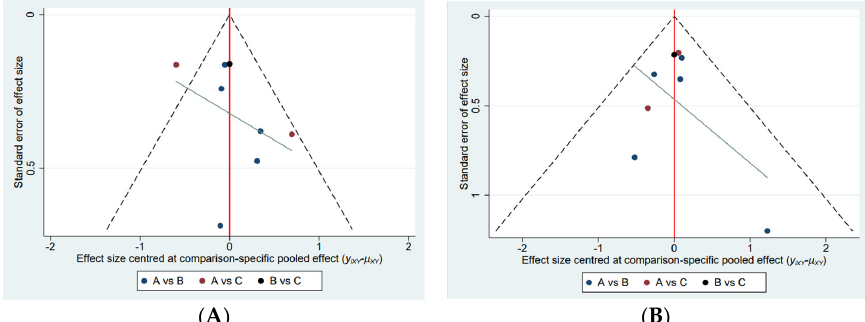
Figure 3. Comparison−adjusted funnel plot. ( A ) Adverse events, ( B ) Efficacy A, Vonoprazan dual therapy; B, vonoprazan triple therapy; C, PPI triple therapy.